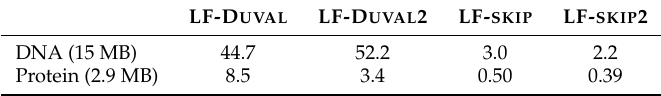
Table 2. Run times in milliseconds on two biological sequences.